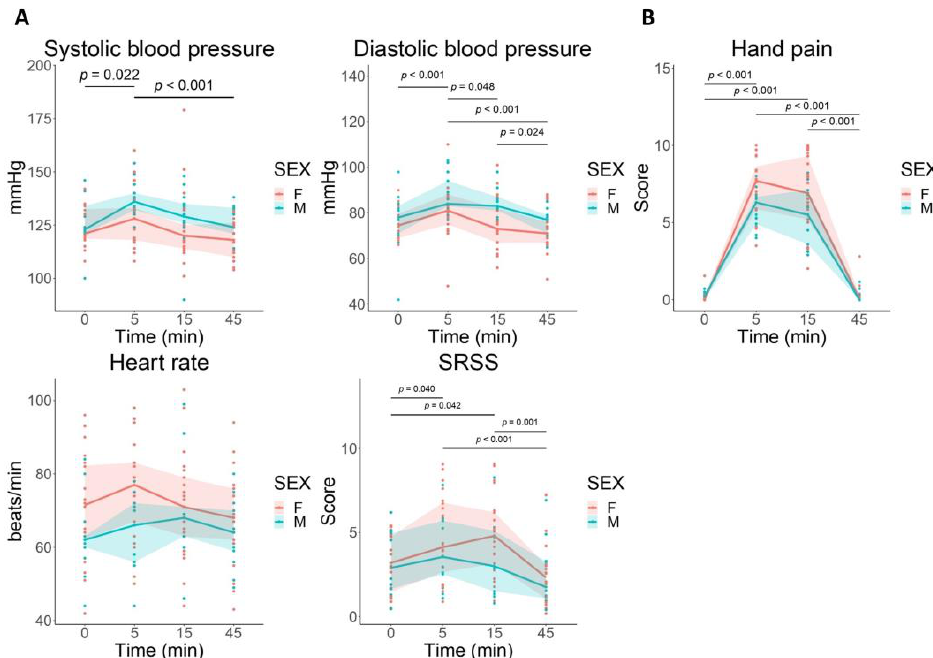
Figure 3. Systemic response to cold pain stress (CPS). The response to stress (change from baseline) was significantly different between males (M: blue circles) and females (F: pink circles). ( A ) A two-way ANOVA revealed significant differences for time and for sex group both in systolic and diastolic blood pressure. A two-way ANOVA revealed significant differences for time but not for sex in heart rate. CPS increased subjective stress rating scale (SSRS), with no differences between M and F groups. ( B ) A two-way ANOVA revealed significant differences for time and for sex group both in hand pain perception. Lines represent the median for each time point and the area represents the 25 and 75 percentiles. F: females; M: males; min: minutes; SSRS: subjective stress rating scale.